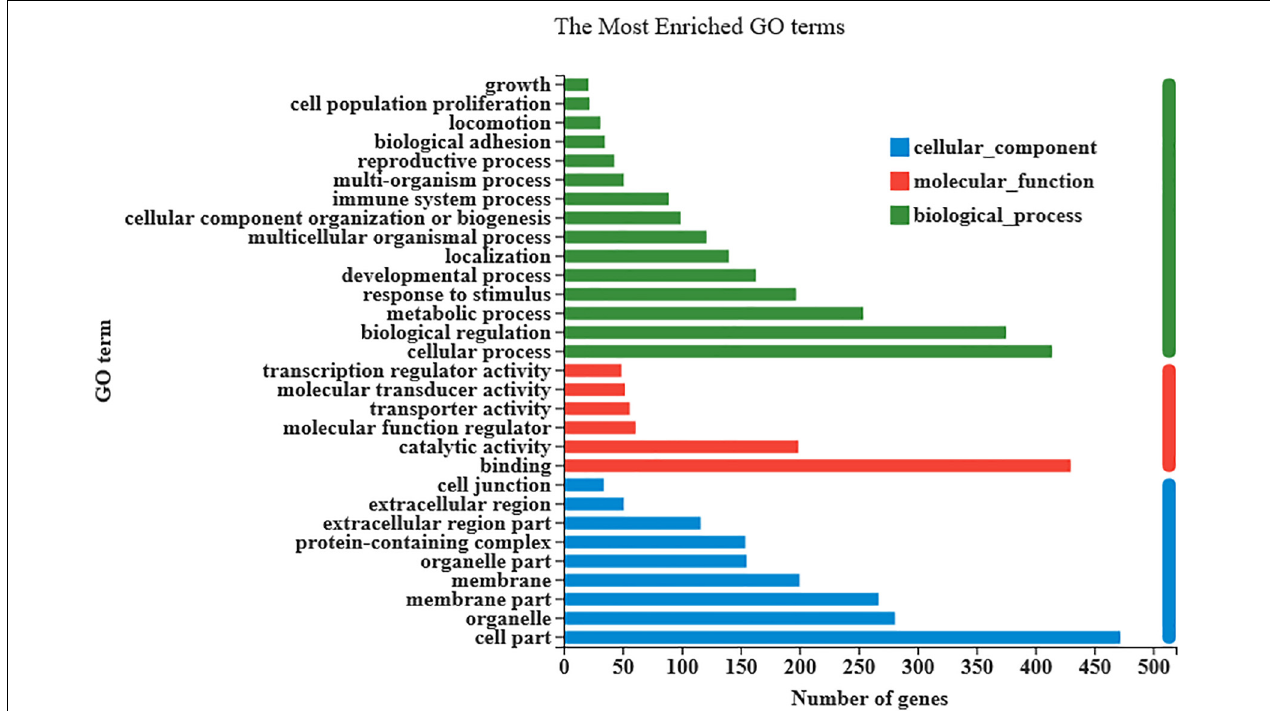
FIGURE 5 | Comparing analysis of relative gene expression in Control and Puerarin group ( n = 4). Control: dietary supplementation with 0 mg/kg Puerarin in the feed concentrate; Puerarin : dietary supplementation with 400 mg/kg Puerarin in the feed concentrate. FABP3, Fatty acid binding protein 3; ACSL1, Long-chain acyl-CoA synthetase 1; SCD, stearoyl-CoA desaturase; FAS, Fatty acid synthase; HSL, Hormone sensitive lipase; ADPN, Adiponectin; and FoxO1, Forkhead transcription factor